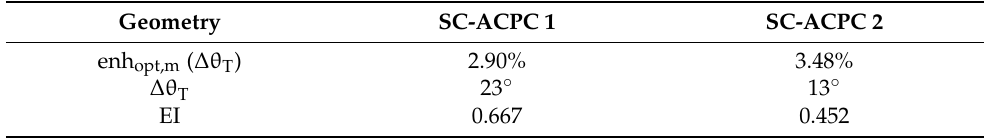
Table 6. Efficiency Index values for SC-ACPC 1 and SC-ACPC